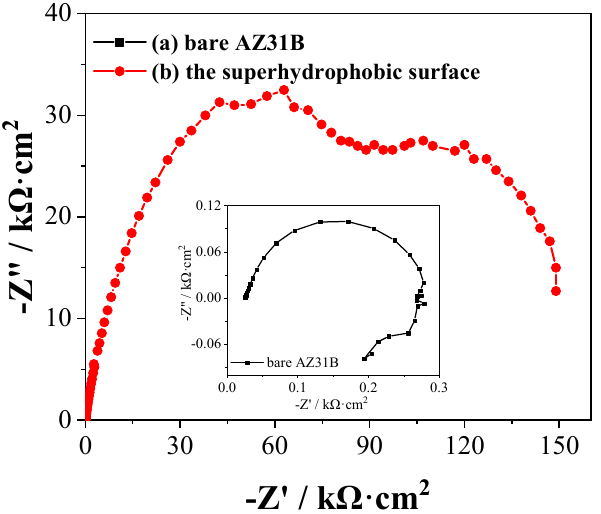
Figure 10. The Nyquist plots obtained from ( a ) pretreated magnesium alloy, ( b ) the PVDF/PFOTES- SiO 2 super-hydrophobic surface on Mg alloy after immersion in 3.5 wt % NaCl aqueous solution for 30 min.